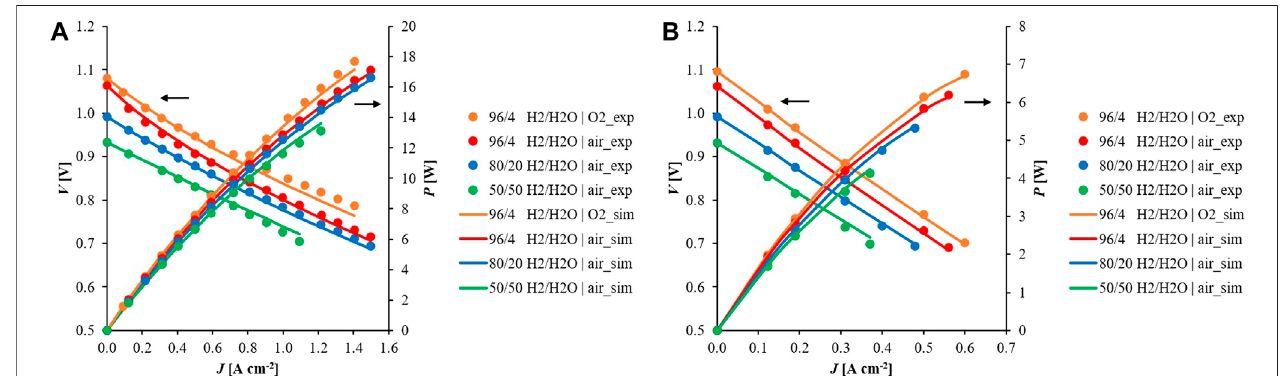
FIGURE 8 | Comparison between (A) ASC and (B) ESC voltages at 800 ° C feeding different fuel and oxidant compositions at anodic and cathodic sides,